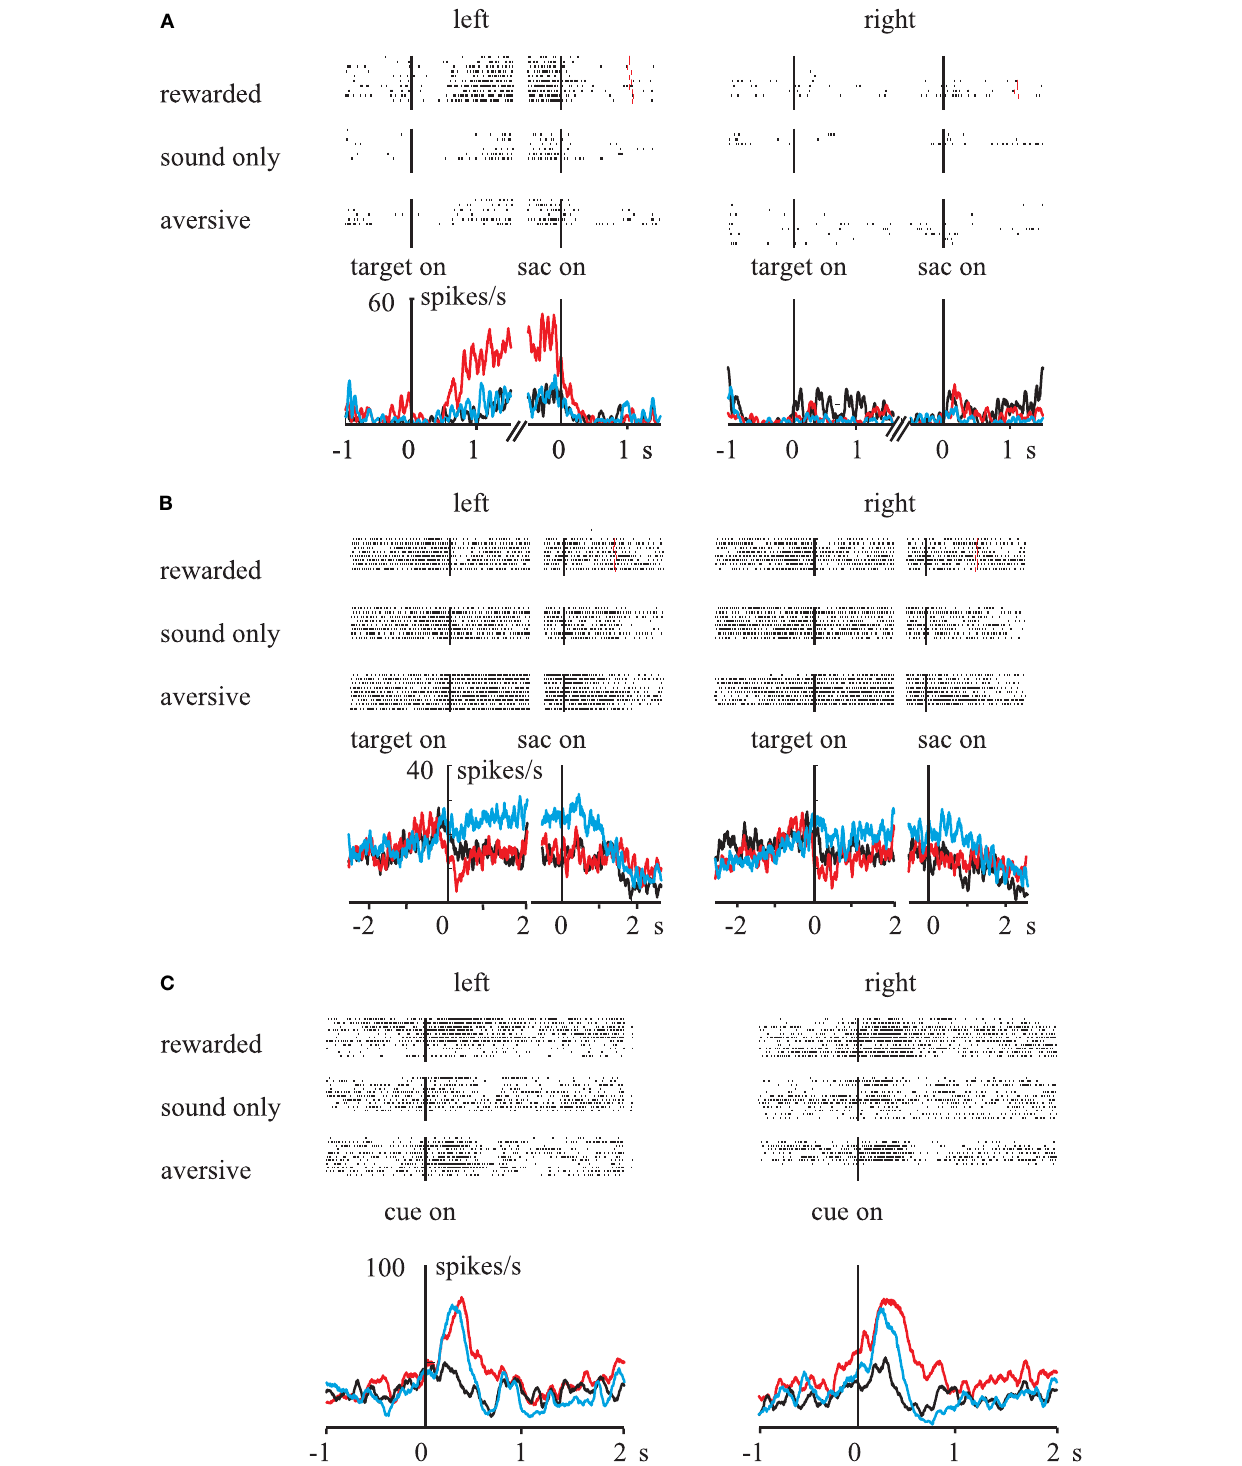
FIGURE 3 | Influences of rewarding and aversive outcomes on activity in the primate LPFC. Raster-histograms of different types of single neurons are displayed. (A) The activity of this neuron increased during rewarded trials when the saccade target was presented in the left visual field. (B) This neuron exhibited higher delay-period activity during aversive trials when the saccade target was on the left. (C) The activity of this